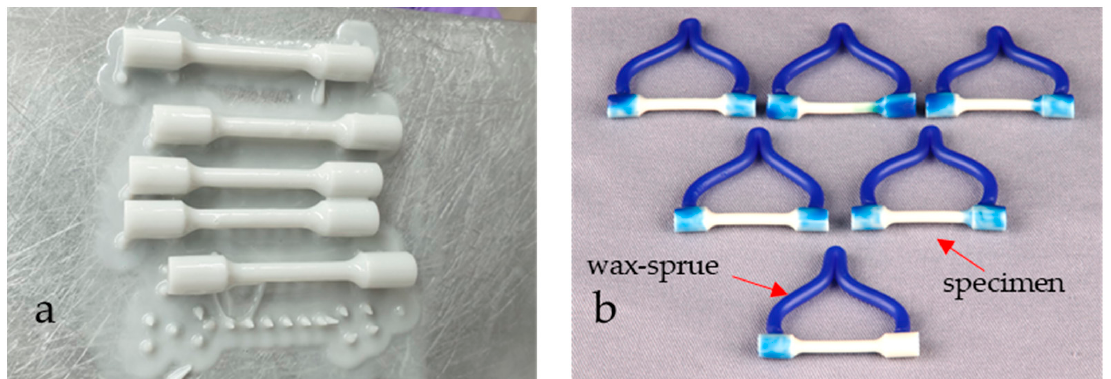
Figure 1. ( a ) Presentation of stereolithography process of the sixth specimen model in photopolymer (3D Dental, Rapid Model Resin, Monocure 3D); ( b ) test specimen model of the control group pre- pared for investing in the investment material.